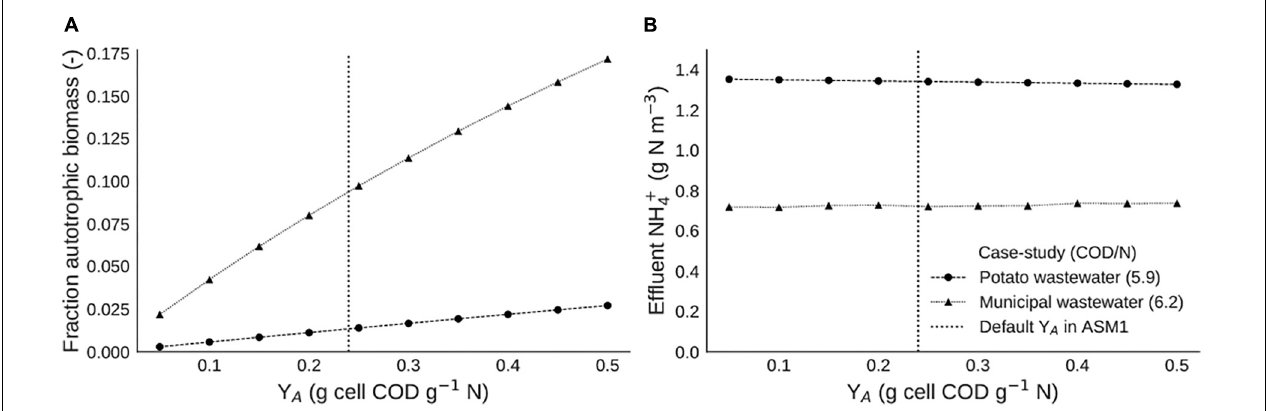
FIGURE 9 | Steady state scenario analysis with different values of nitrifier yield (Y A ), with (A) the autotrophic biomass fraction and (B) the effluent ammonium concentration.